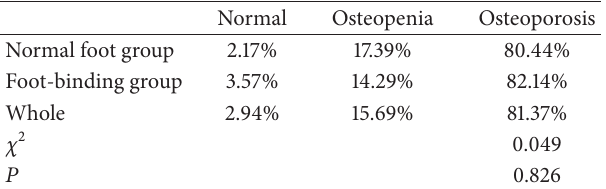
Table 5: Osteoporosis diagnosis rate between normal foot group ( 𝑛 = 46 ) and foot-binding group ( 𝑛 = 56 ). Normal Osteopenia Osteoporosis Normal foot group 2.17% 17.39% 80.44% Foot-binding